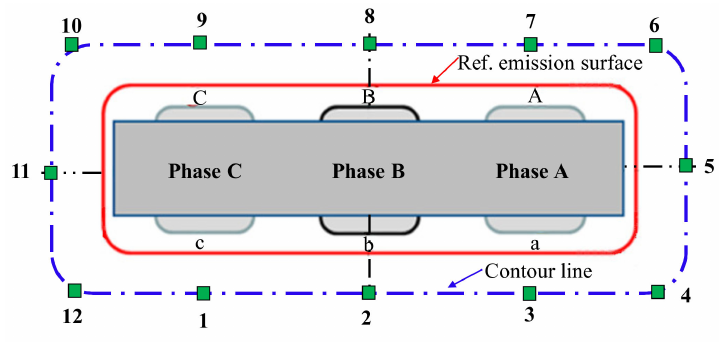
Figure 9. Location of measurement